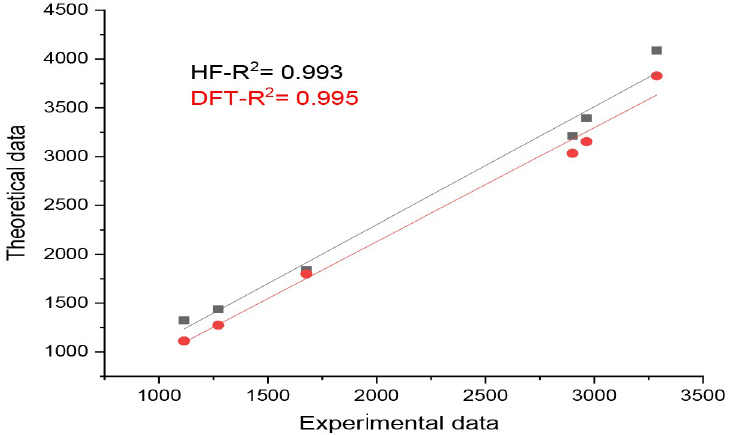
Fig 7. Correlation between observed and calculated IR vibrational frequencies of methyl